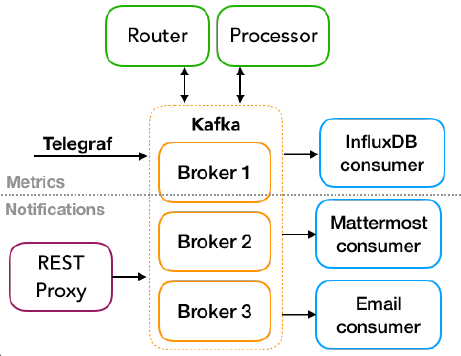
Fig. 2. Kafka cluster